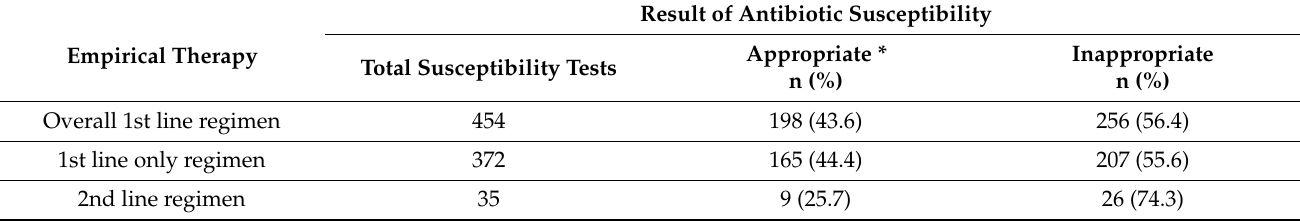
Table 5. Empirical treatment and antibiotic susceptibility pattern.